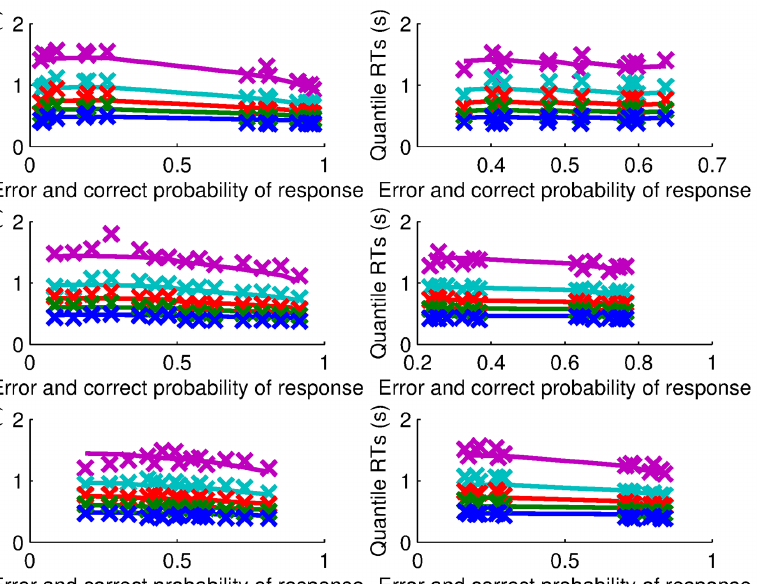
Figure 6. Quantile probability plots showing predictions of the model (recovered from the parameters averaged across individuals and represented by the lines) and the data (averaged across individuals and represented by 'x'). The different colours reflect the different quantiles (.1, .3, .5, .7, .9) of the RT distribution for each condition.